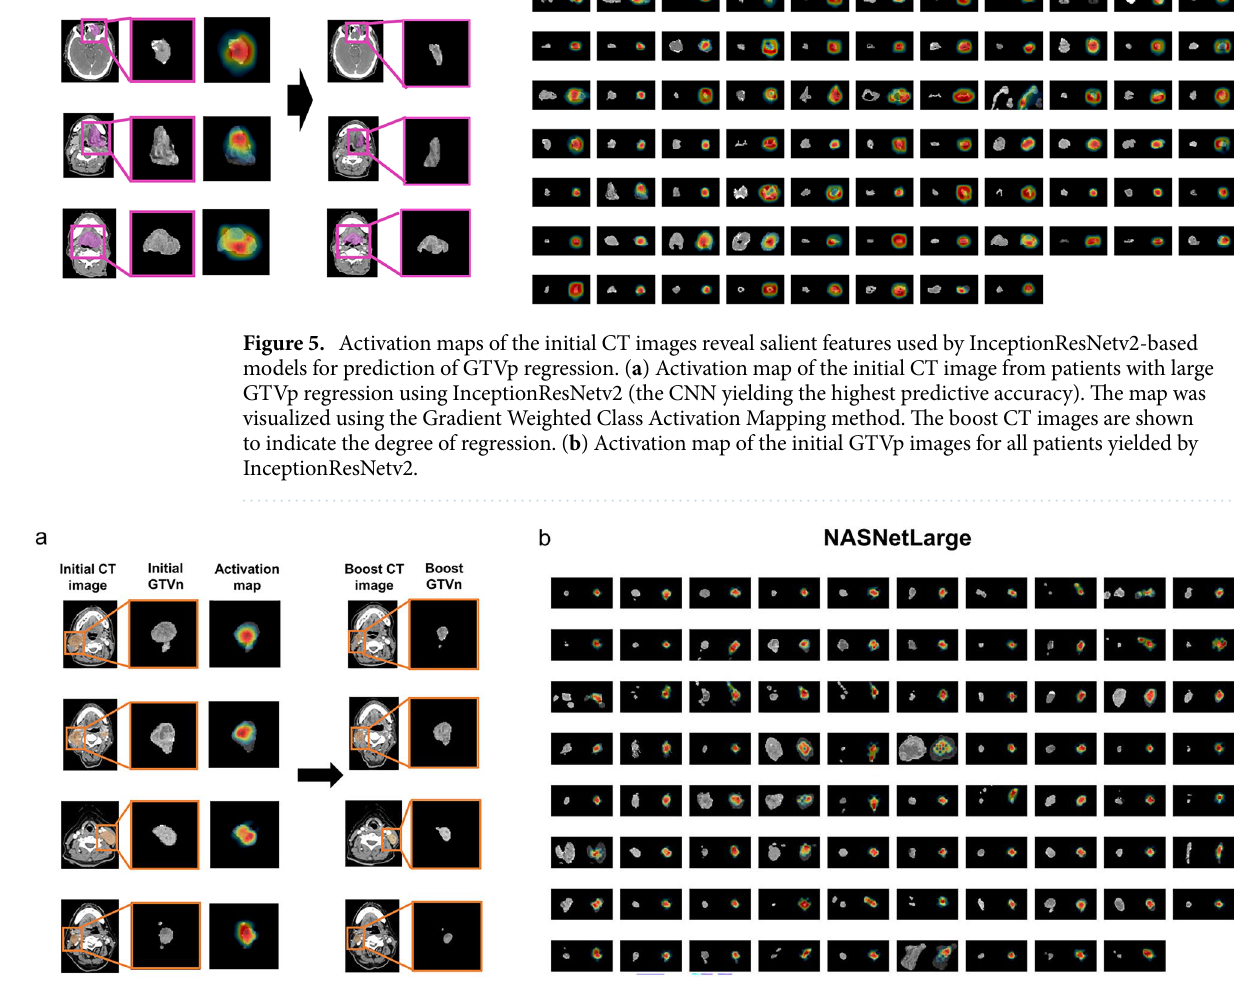
Figure 6. Activation maps of the initial CT images reveal salient features used by NASNetLarge-based models for prediction of GTVn regression. ( a ) Activation map of the initial CT image from a patient with large GTVn regression using NASNetLarge, the CNN yielding the highest prediction accuracy. The boost CT images are shown to illustrate the degree of regression. ( b ) Activation maps for all patients using